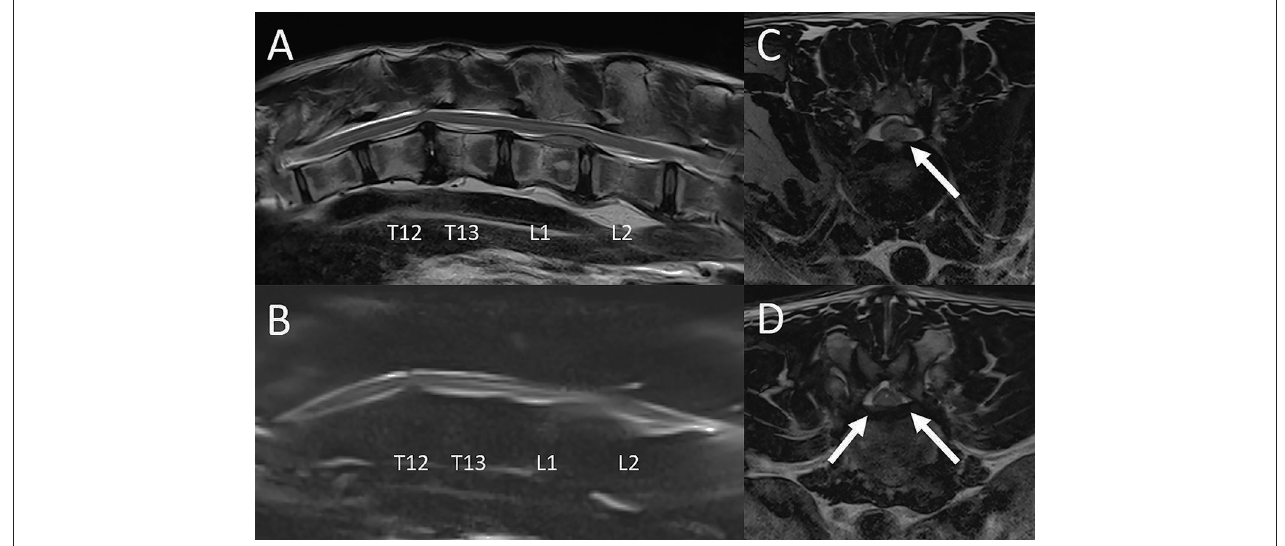
FIGURE 8 | Intervertebral disc disease in a tiger. Sagittal T2-W image (A) , sagittal MR myelogram [HASTE; (B) ], and transverse T2-W images at L1-2 (C) and T12-13 (D) . There is variable degree decrease of normal T2 hyperintensity of all intervertebral discs included in the scan field of view. (A) At L1-2 there is a moderate amount of intermediate intensity extradural material associated with the vertebral canal, extending from the level of the L1-2 intervertebral disc space cranially to mid-body L1. There is intramedullary hyperintensity of the spinal cord over the length of the lesion and extending to mid-body L2. The T12-13 intervertebral disc and to a lesser degree the T13-L1 intervertebral disc protrude into the ventral aspect of the vertebral canal. (B) On the MR myelogram there is complete circumferential attenuation of the subarachnoid space over the length of L1 and cranial L2. The ventral subarachnoid space at T12-13 is dorsally deviated but remains visible. (C) Herniated disc material + /- associated hemorrhage is located in the left ventral aspect of the vertebral canal at L1-2 (arrow), causing moderate spinal cord compression. (D) At T12-13 herniated disc material is located in the ventral aspect of the vertebral canal and is contiguous with the annulus of the intervertebral disc (arrows). There is only mild spinal cord compression from ventral at this level. The findings are consistent with acute intervertebral disc extrusion + /- associated extradural hemorrhage at L1-2 causing moderate spinal cord compression from left ventral. Spinal cord hyperintensity at this level is consistent with edema. There are concurrent chronic intervertebral disc protrusions, most notably at T12-13, not causing significant spinal cord